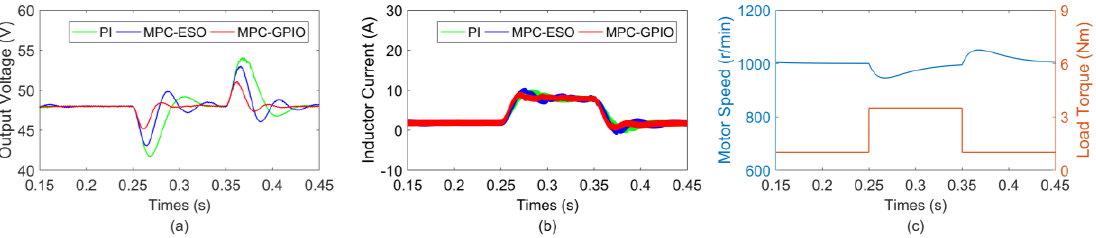
Figure 9. Dynamic response of converter with electric machine load: ( a ) output voltage; ( b ) inductor current; ( c ) motor speed and load torque.